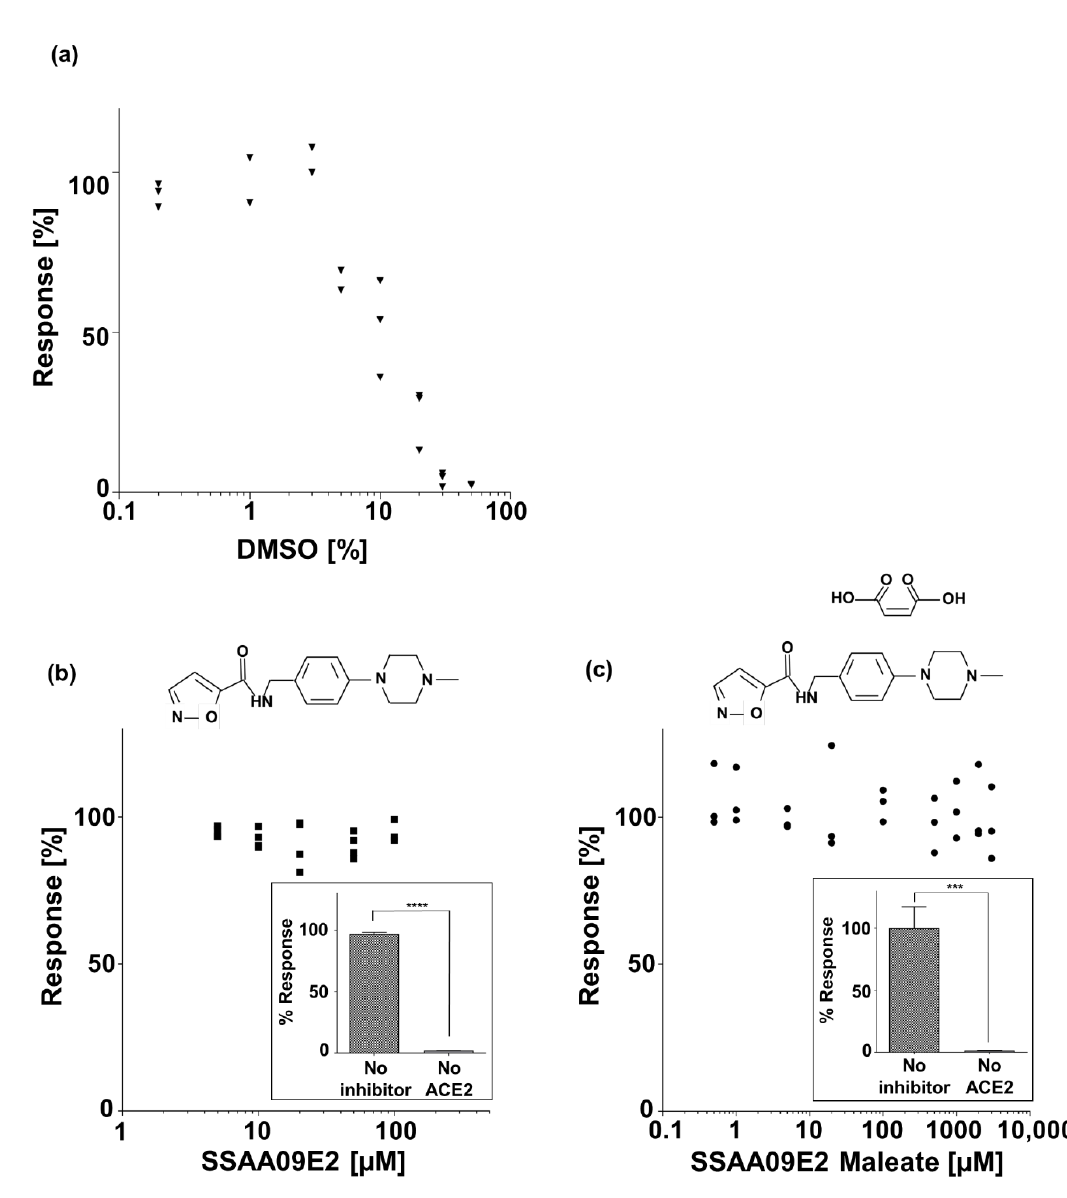
Figure 5. Assessing a small molecule (SSAA09E2) as an inhibitor of the S1-ACE2 interaction. In each binding curve, the signals were normalized to the signal at 0 µM of inhibitor, which was set as 100% Response. ( a ) A binding curve of S1-ACE2 interaction with increasing concentrations of DMSO. The experiment was repeated three times ( n = 3 ) . ( b ) A binding curve of S1-ACE2 interaction with increasing concentrations of SSAA09E2 in a final concentration of 1% v/v DMSO. The experiment was repeated three times ( n = 3). (Inset) Abbreviations: “No inhibitor”, conjugated magnetic beads with the attached S1 protein were incubated with biotinylated ACE2 protein and SA-PE. “No ACE2”, conjugated magnetic beads with the attached S1 protein were incubated with the inhibitor and SA-PE, but without the ACE2 protein. Measurements were normalized to the signal (designated as 100% Response) when S1 binds with ACE2 without an inhibitor and without DMSO. Error bars represent the standard error of the mean value of four experiments ( n = 4 ) . Four asterisks (****) indicate a statistical significance of p < 0.0001. ( c ) A binding curve of S1-ACE2 interaction with increasing concentrations of SSAA09E2 Maleate dissolved in DDW. The experiment was repeated three times ( n = 3). (Inset) Abbreviations: “No inhibitor”, conjugated magnetic beads with the attached S1 protein were incubated with biotinylated ACE2 protein and SA-PE. “No ACE2”, conjugated magnetic beads with the attached S1 protein were incubated with the inhibitor and SA-PE, but without the ACE2 protein. Measurements were normalized to the average signal (designated as 100% Response) when S1 binds with ACE2 without an inhibitor. Error bars represent the standard error of the mean value of five experiments ( n = 5 ) . Three asterisks (***) indicate a statistical significance of p <